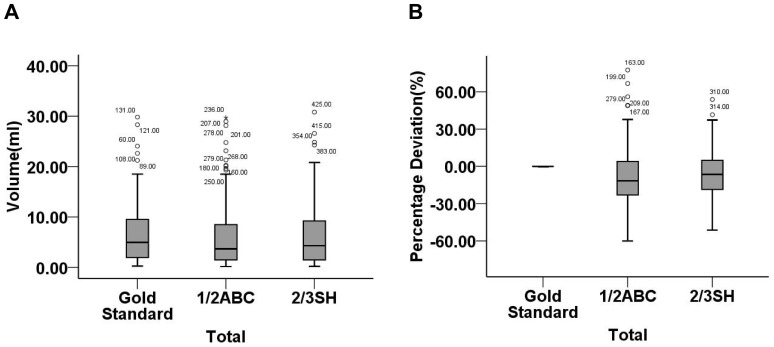
Hematoma volumes (ml) and percentage deviations (%) for total 147 infratentorial hemorrhages calculated by gold standard, formula 1/2ABC and 2/3SH.(A) the comparison of three methods in hematoma volume was statistically indistinguishable (P = 0.700); (B) formula 1/2ABC and 2/3SH underestimated hematoma volume by −11.59(−23.07, 4.13)% and −6.51(−18.58, 4.88)%, respectively. CAVA, computer-assisted volumetric analysis.